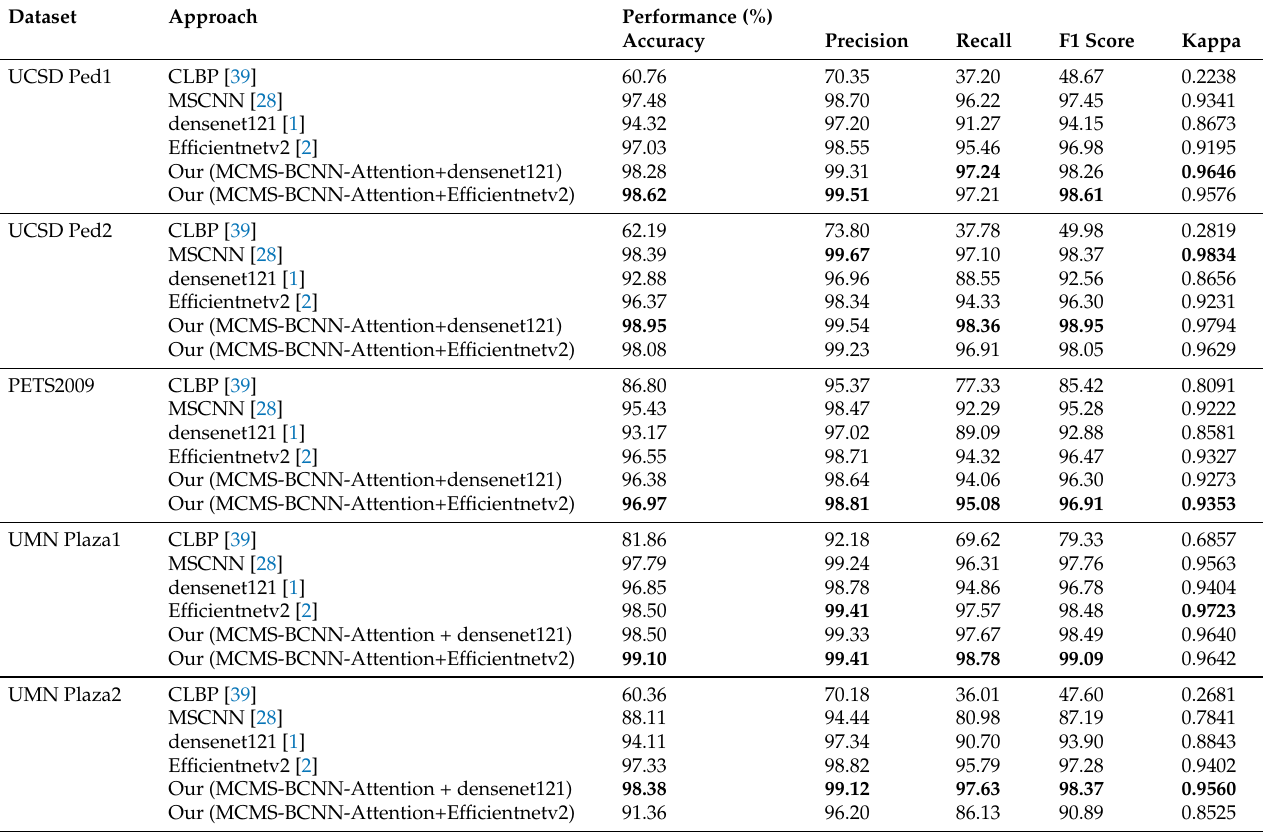
Table 6. Performance comparison with existing